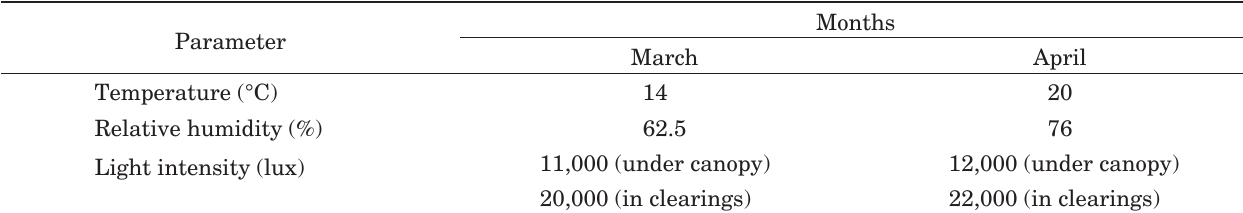
Table 3. Average values of climatic parameters (temperature, relative humidity and light intensity) recorded at Ulignano (Pisa) in March and April of 2004 and